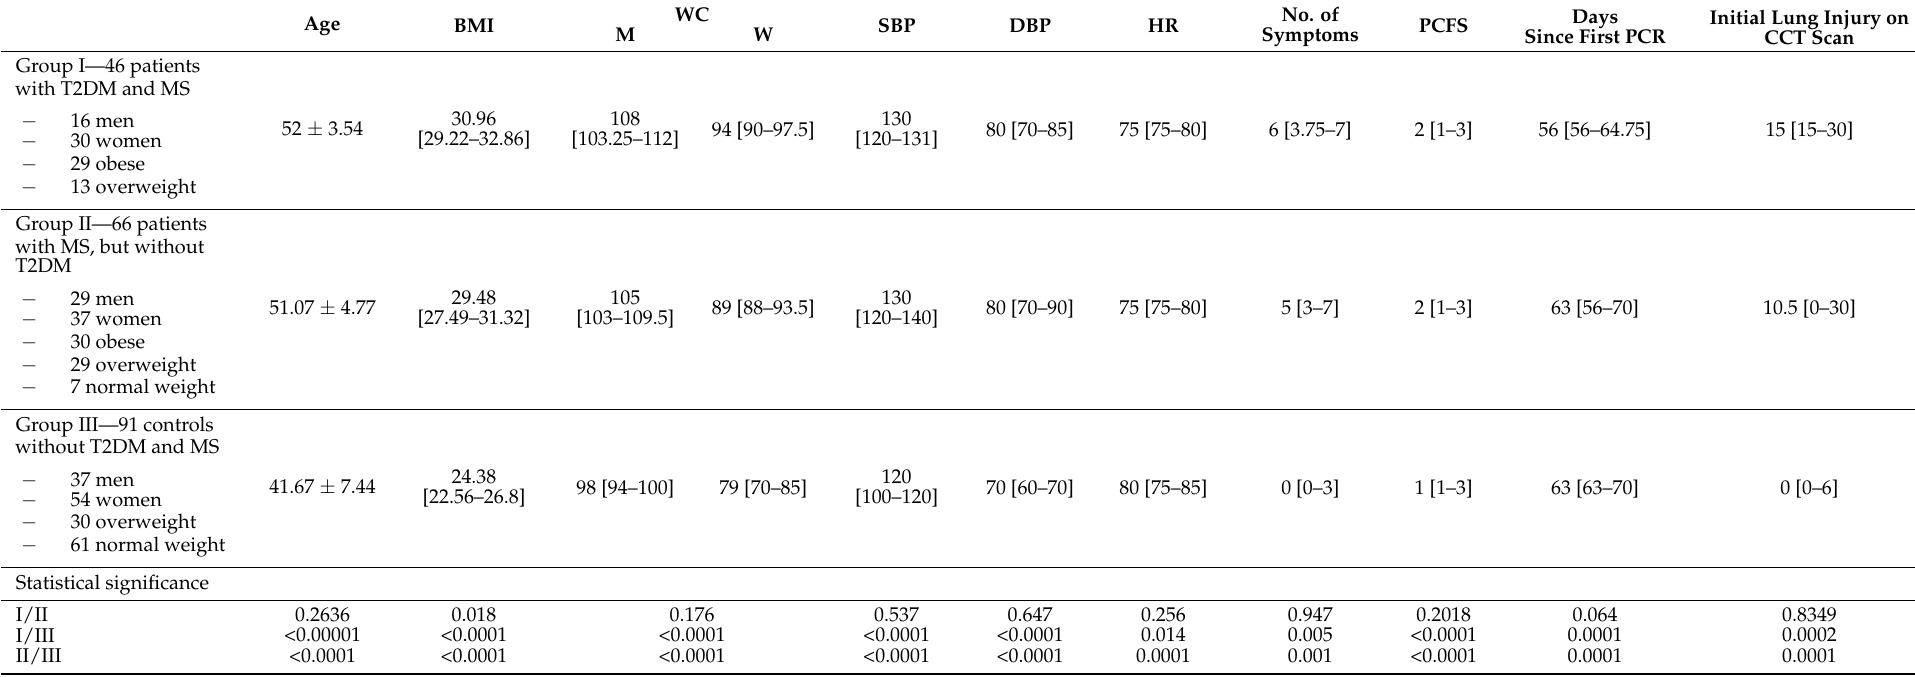
Table 1. Patients’ clinical